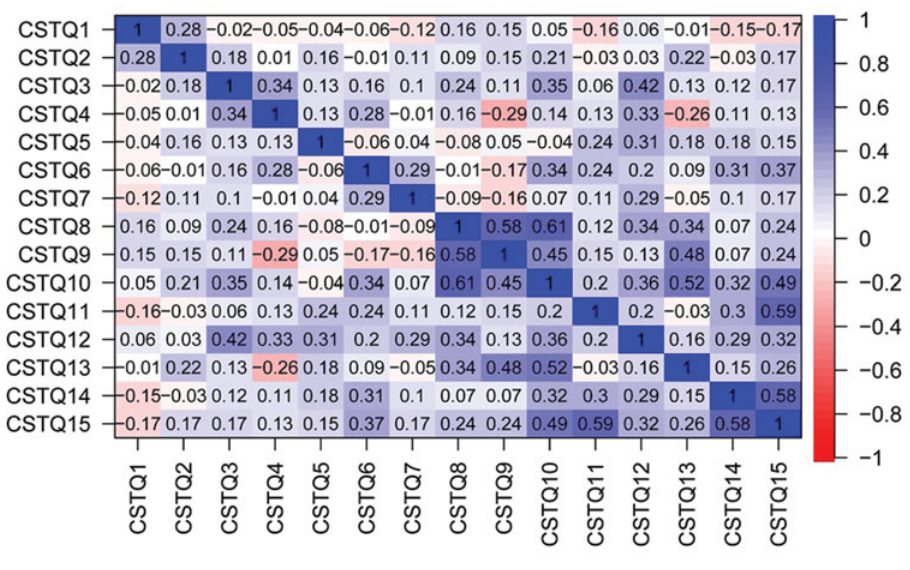
FIGURE 1 (Colour online) Correlation structure of 15 items for factors of critical thinking and transformative unlearning.